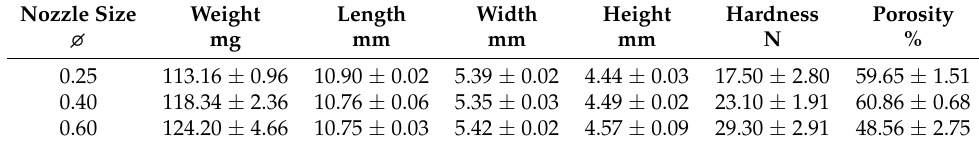
Table 5. The effect of the nozzle size used during 3D printing on a variety of caplet properties.